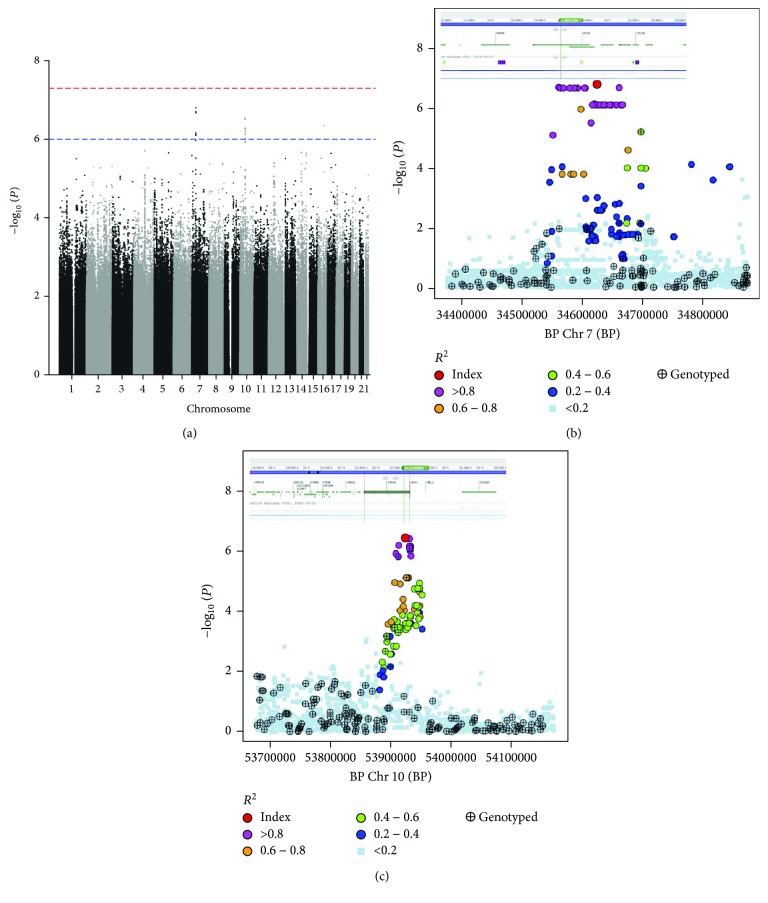
Results of GWAS analysis for Chlamydia trachomatis seropositivity using EMMAX. (a) Manhattan plot showing index SNPs with p
EMMAX < 1 × 10–6. There were two regions of within-gene SNP association with Chlamydia trachomatis serological response. (b) The Chr 7: 34560375–34666861 region, within the nonprotein-coding NPSR1 antisense RNA 1 (NPSR1-AS1) and immediately upstream of the G protein-coupled receptor coding neuropeptide S receptor 1 (NPSR1). (c) The Chr 10: 53873323–56733116 region, within the gene encoding protein kinase, CGMP-dependent, type I (PRKG1), a mediator of the nitric oxide/cGMP signalling pathway, which has roles in immune function and GPCR signalling.